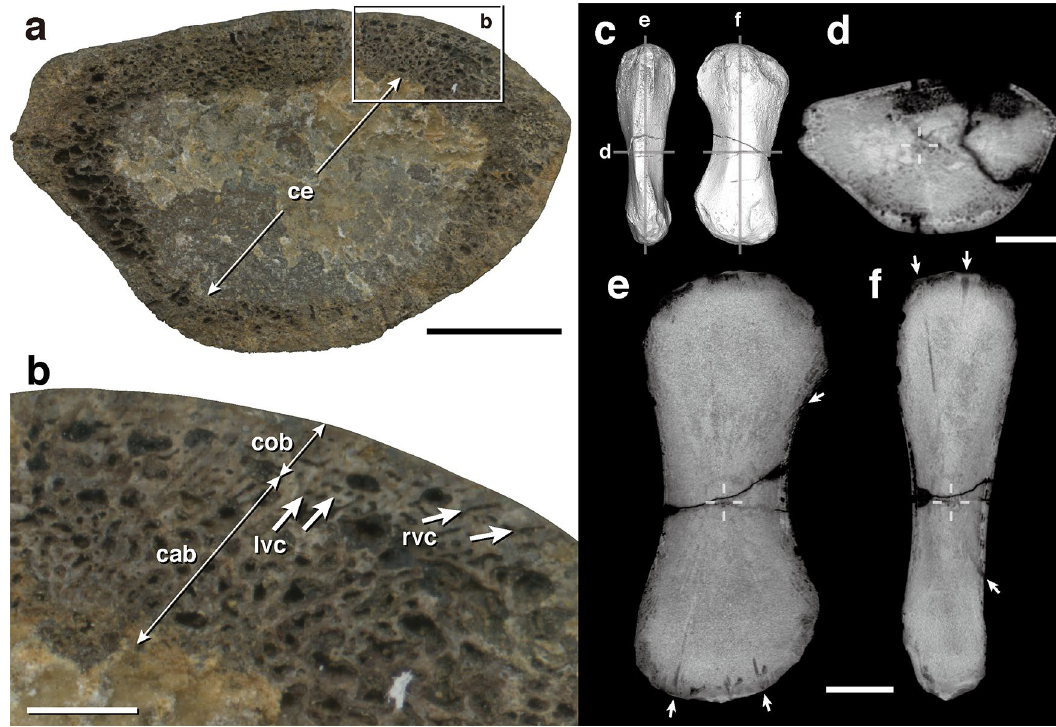
Figure 8. Internal microanatomy of humeral specimen NSM PV 24995. ( a ) Cross-sectional view showing cancellous inner trabecular organization. Intertrabecular spaces around the center are occupied by sedimentary carbonate mineral cementation. (b) Close-up view of a superficial area. Enlarged area is indicated by a rectangle in ( a ). (c–f) CT scan images. (c) Diagram showing sectional positions in ( d – f ). (d) transverse, (e) sagittal, (f) sagittal plane. Arrows indicate nutrient canals; broken crosses indicate the position of growth center. cab cancellous bone, ce cementation, cob compact bone, lvc longitudinal vascular canals, rvc radial vascular canals. Scale bars equal ( a,d ) 1 cm, ( b ) 2 mm, and ( e,f ) 2